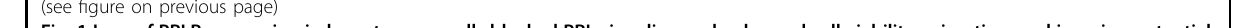
Fig. 1 Loss of PRLR expression in breast cancer cells blocked PRL signaling and enhanced cell viability, migration, and invasion potential. a , b Immunoblot analyses of total cell lysates of MCF-7/WT, MCF-7/NT, and MCF-7/PRLRKO (SG1, SG2, and SG3) as well as SKBR-3/WT, SKBR-3/NT, and SKBR-3/PRLRKO (SG1, SG2, and SG3) following stimulation with rhPRL (250 ng/ml) for 15 min using antibodies against Phospho-STAT5a/b, STAT5a/b, and β -tubulin. c , d MTT assays were performed using MCF-7/WT, MCF-7/NT, and MCF-7/PRLRKO (SG1, SG2, and SG3) cell lines as well as SKBR-3/WT, SKBR-3/NT, and SKBR-3/PRLRKO (SG1, SG2, and SG3) cell lines for 24, 48, and 72 h. Results are expressed as mean ± SEM of four replicates of three independent experiments **** P < 0.0001 (two-way ANOVA). e MCF-7/WT, MCF-7/NT, and MCF-7/PRLRKO (SG1, SG2, and SG3) cell lines were subjected to scratch wound assay. Cells were analyzed at 24, 48, and 72 h. Upper panels show representative cell migration experiment. Lower panels quanti fi cation of results of four replicates of three independent experiments expressed as mean ± SEM **** P < 0.0001 (two-way ANOVA). f Quantitative invasion assays of MCF-7/WT, MCF-7/NT, and MCF-7/PRLRKO (SG1, SG2, and SG3) cell lines. Upper panels show representative cell invasion experiment. Lower panel, quanti fi cation of results of four replicates of four independent experiments **** P < 0.0001 (one-way ANOVA). g SKBR-3/WT, SKBR-3/NT, and SKBR-3/PRLRKO (SG1, SG2, and SG3) cell lines were subjected to scratch wound assay. Cells were analyzed at 24 and 48 h. Upper panels show representative cell migration experiment. Lower panels show quanti fi cation of results of four replicates of three independent experiments expressed as mean ± SEM of *** P 0.00054 (two-way ANOVA). h Quantitative invasion assays of SKBR-3/WT, SKBR-3/NT, and SKBR-3/PRLRKO (SG1, SG2, and SG3) cell lines. Upper panels show representative cell invasion experiment. Lower panels show quanti fi cation of results of four replicates of three independent experiments * P 0.012 (one-way